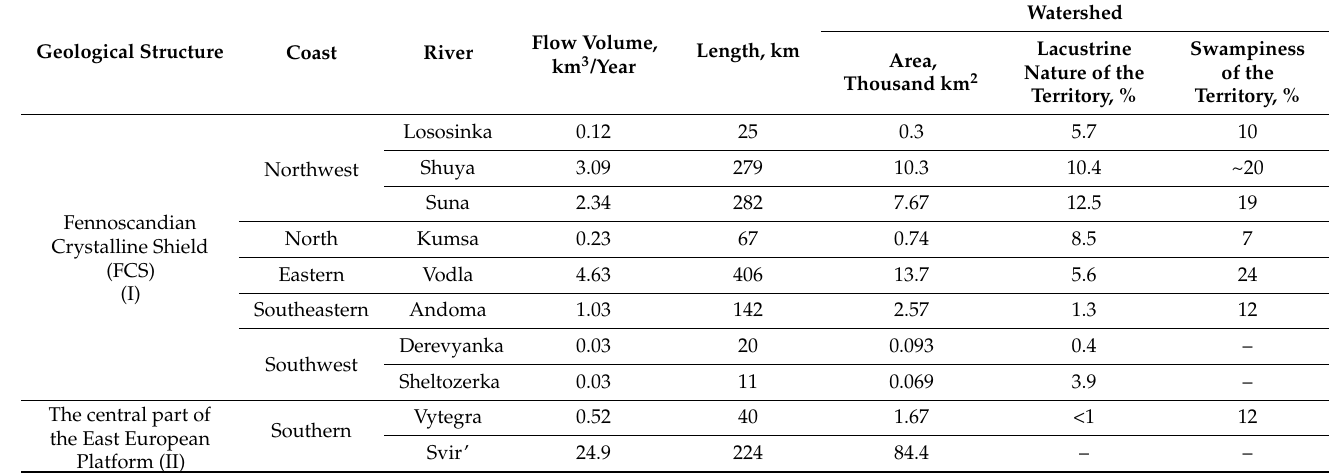
Table 1. Characteristics of the tributaries and the source of Lake Onego and their catchments